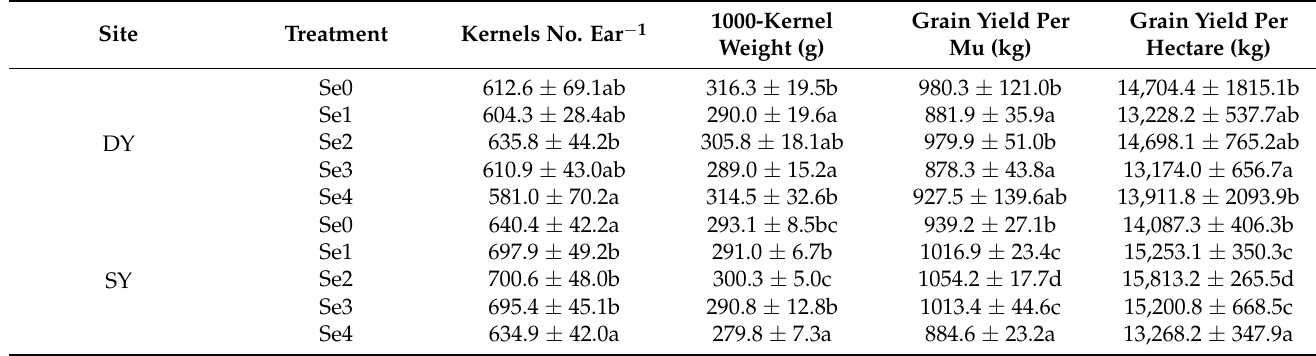
Table 1. Effects of Se fertilizer application on maize yield at locations DY and SY.